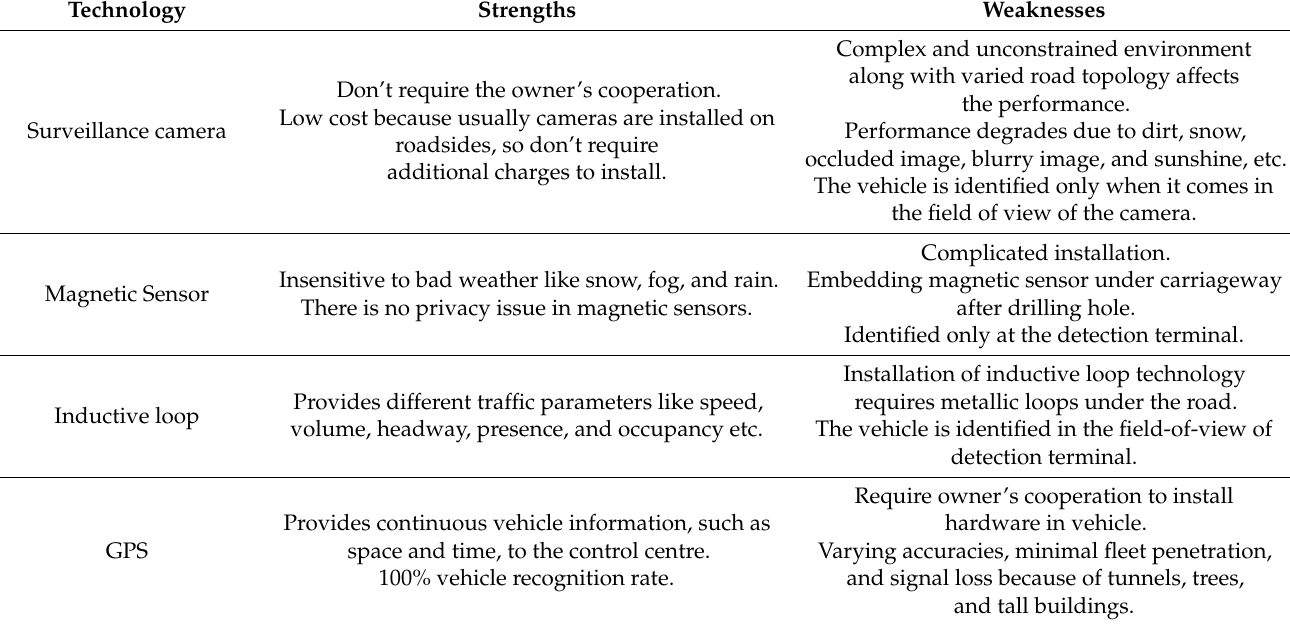
Table 1. Summary of strengths and weaknesses of different vehicle re-id technologies. Technology Strengths Weaknesses